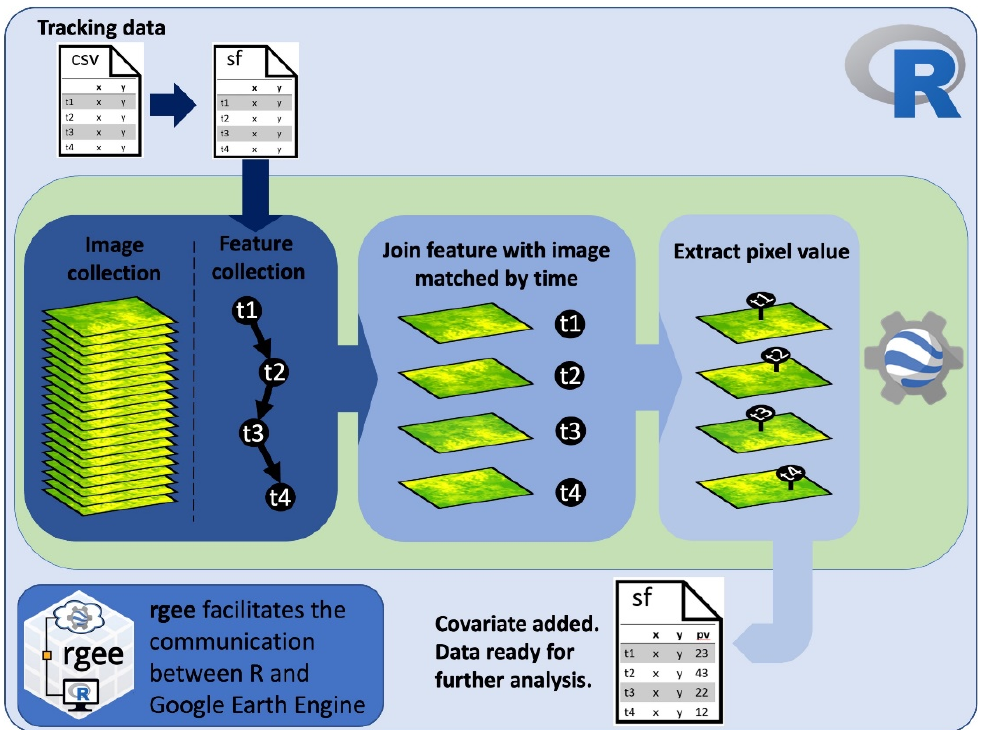
Figure 1. Code workflow diagram showing the overall process to extract pixel values at animal- tracking locations from the most temporally proximate image in a time series using R and Google Earth Engine.